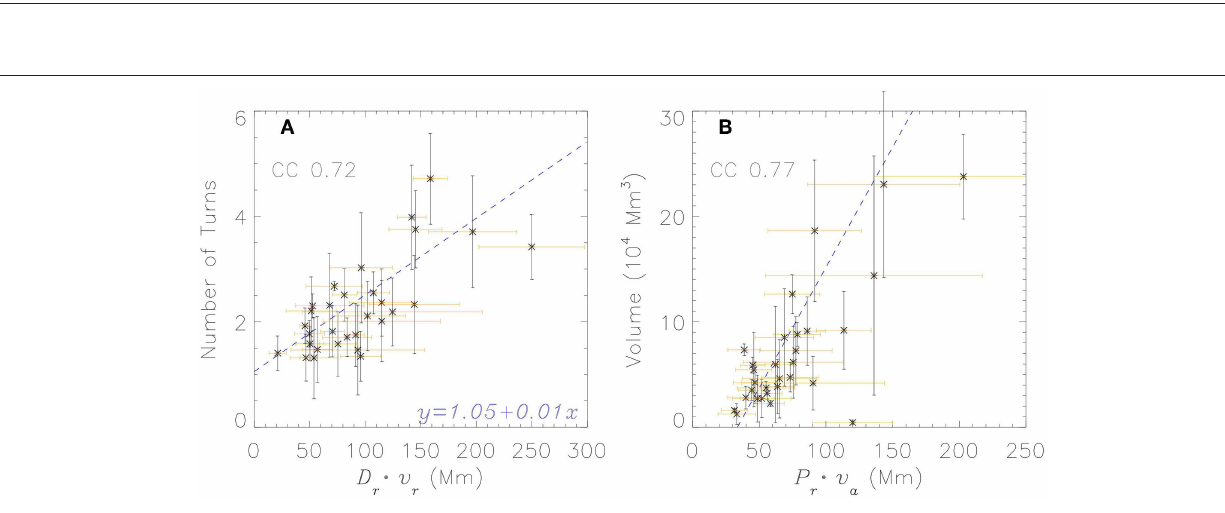
Frontiers in Astronomy and Space Sciences |